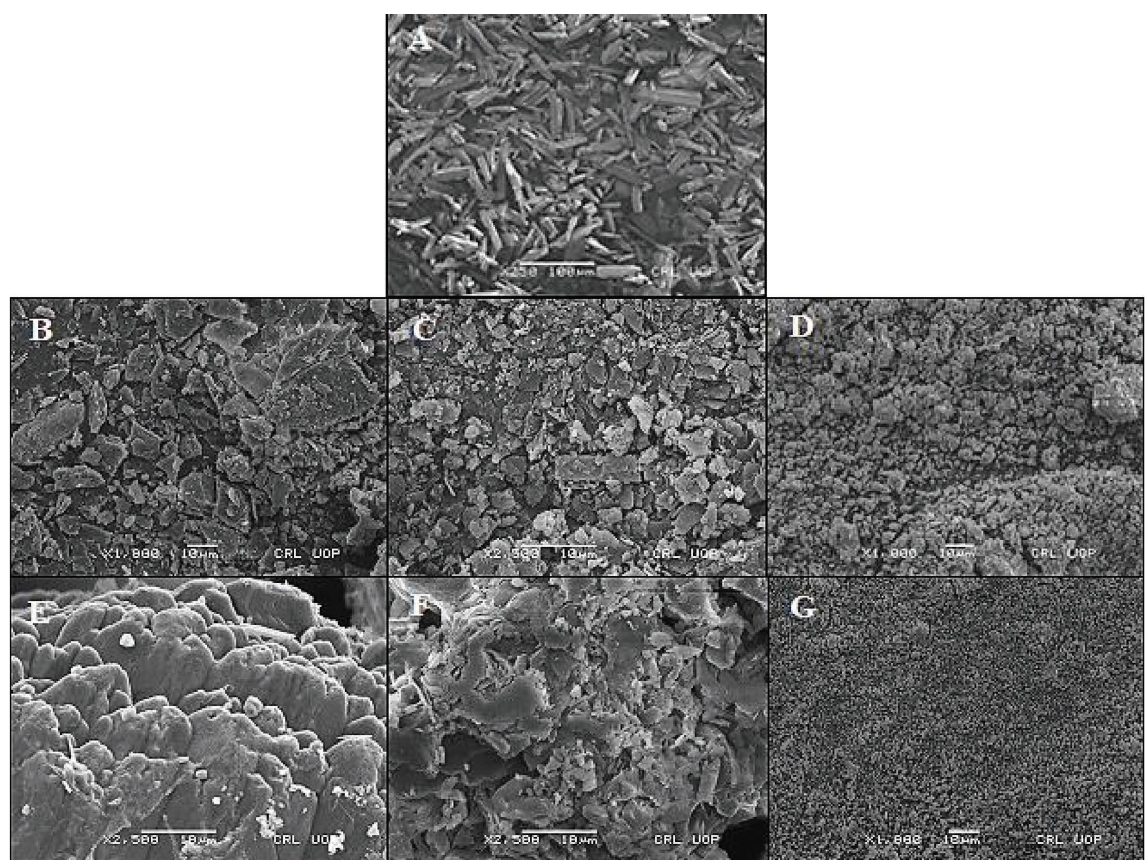
Figure 4: SEM micrographs of moxifoxacin (a) and its metal complexes 1–6 (b–g),